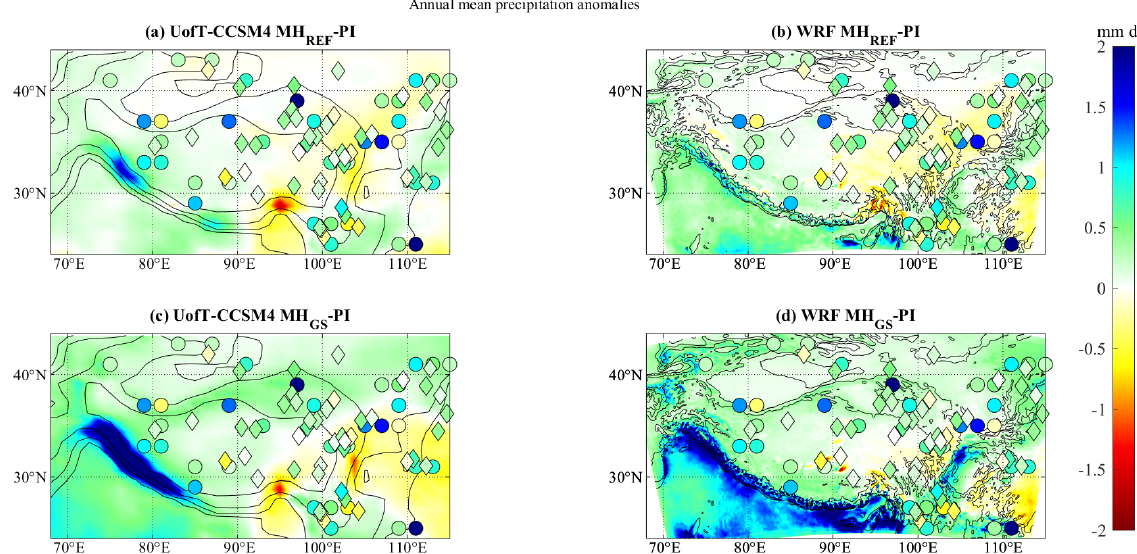
Figure 5. Annual mean precipitation anomalies (mmd − 1 ) for (a, b) MH REF and (c, d) MH GS in (a, c) UofT-CCSM4 and the (b, d) WRF ensemble mean. Reconstructed precipitation differences between the MH and present day from Bartlein et al. (2011) and Herzschuh et al. (2019) are plotted as circles and diamonds, respectively. The topography contours of 500, 1000, 2000, and 4000m are also